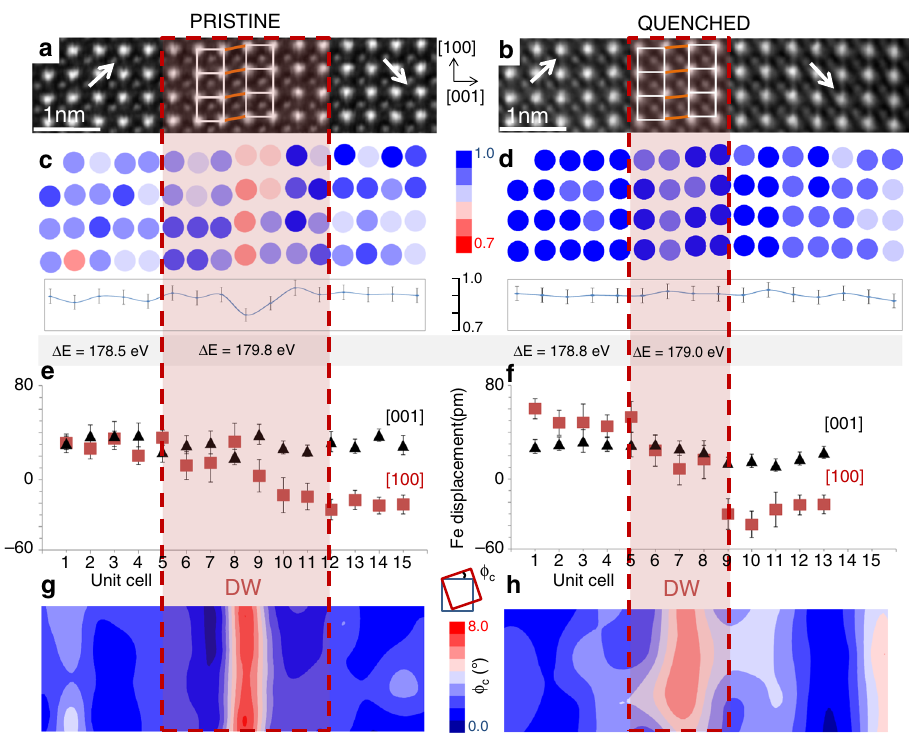
Fig. 2 Defect analysis and atomic structure of DWs in pristine and quenched BiFeO 3 . HAADF-STEM image in [010] zone axis of a 109° DW in a pristine and b quenched BiFeO 3 with corresponding c , d normalized distribution map of Bi-column intensities and average intensity pro fi les across the DW region; the values of Δ E between the O-K and Fe-L 3 edges measured on and off the DW are also shown in the panels c , d ; e , f average of Fe displacements determined from individual unit-cell rows and measured along [001] and [100] directions; g , h lattice-strain map represented in terms of lattice-distortion angle measured in [001] direction ( ϕ c ). The DW region is indicated by a dashed red box. In panels (a,b) the arrows indicate the direction of the Fe displacements from the centre of the Bi sublattice; enlarged distances between the sheared Bi atoms columns (shear lattice strain) inside the DWs are indicated by red lines. Error bars in the intensity line pro fi les in panels c , d represent the standard deviation of the intensity measurements performed inside domain regions (~4% relative). Error bars in panels e , f represent the standard deviation of the displacement measurements across the